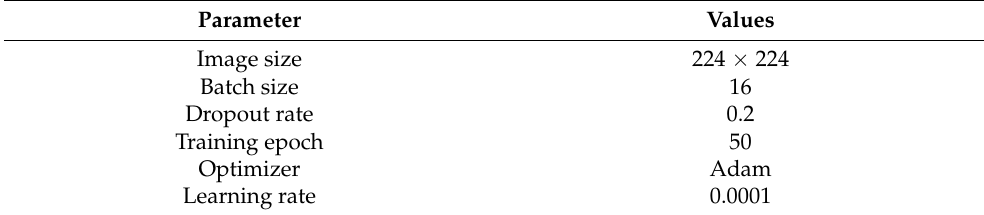
Table 3. The hyperparameter settings of the deep neural networks.